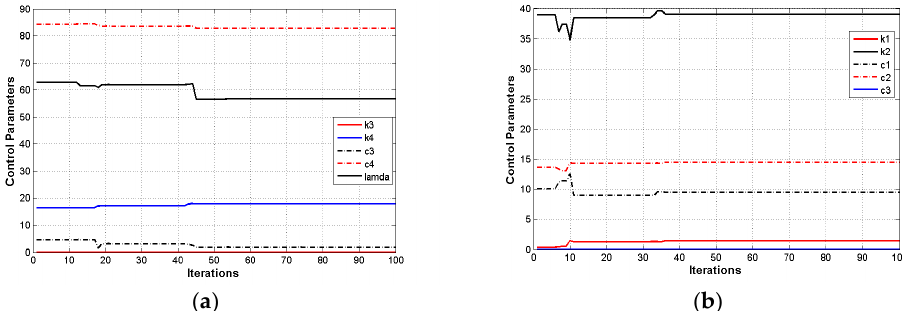
Figure 5. Evolution of the optimized parameters versus iterations: ( a ) conventional block- backstepping controller; ( b ) adaptive block-backstepping controller.